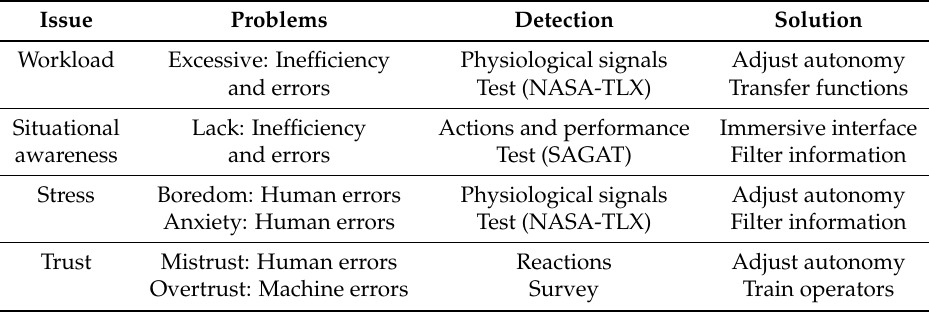
Table 1. Human factors in multi-robot